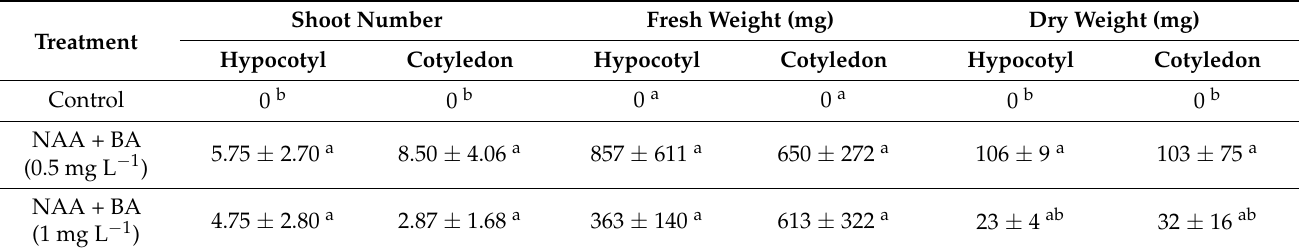
Table 1. The effect of different concentrations of plant growth regulators on growth and development parameters of callus tissues in Artemisia spicigera . Shoot Number Fresh Weight (mg) Treatment